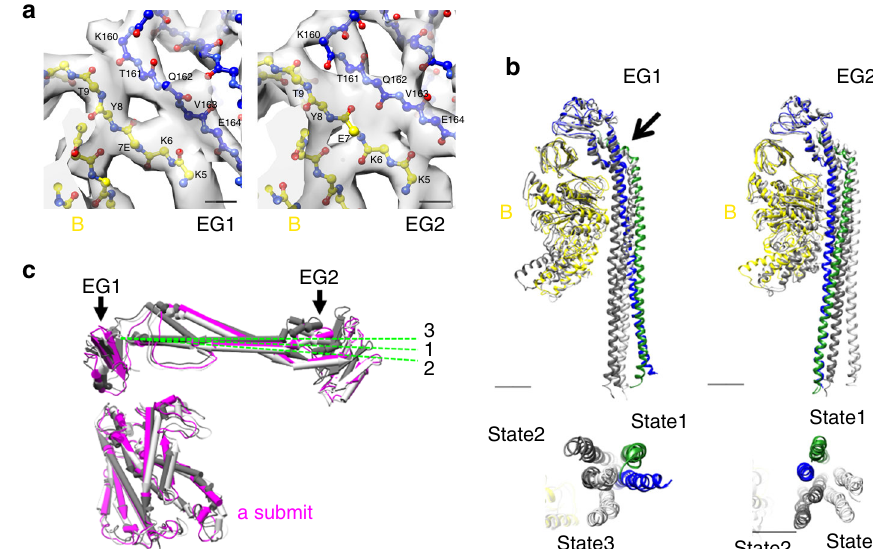
Fig. 3 Structure of the peripheral stator subunits. a Close-up views of the interaction surface of B- and E-subunits in state1. Residues are depicted in sticks format and experimental maps are shown in semi-transparent gray. Scale bar, = 3 Å. b Circular motions of EG1 and EG2 during transition of three rotational states. The E-subunit in state1 is colored blue, and the G-subunit is colored green. E- and G-subunits in state2 are shown in dark gray, and those in state3 are shown in light gray. These subunits are superimposed at the N-terminal β -barrel domain of the corresponding B-subunit. The arrow indicates the pivot point of the right handed coiled-coil of the EG1. The lower panels are bottom views of the N-terminal region of the EG-subunits. Scale bar, 20 Å. c Comparison of the N-terminal domain of a-subunit in three states. Subunits are superimposed at the C-terminal domain of the a-subunit. These subunits in state1 – 3 are colored in magenta, dark gray, and light gray,